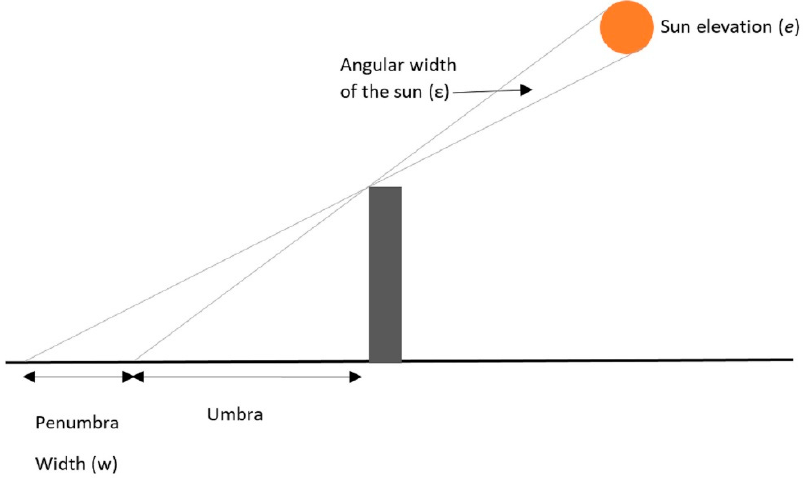
Figure 2. Penumbra width extent from sun elevation, building height and angular width of the Sun. Adopted from Dare [4].